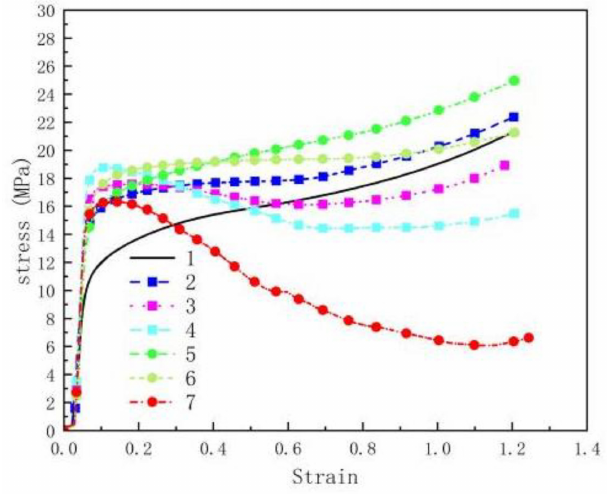
Figure 4. Quasi-static compressive stress-train curves of different reactive